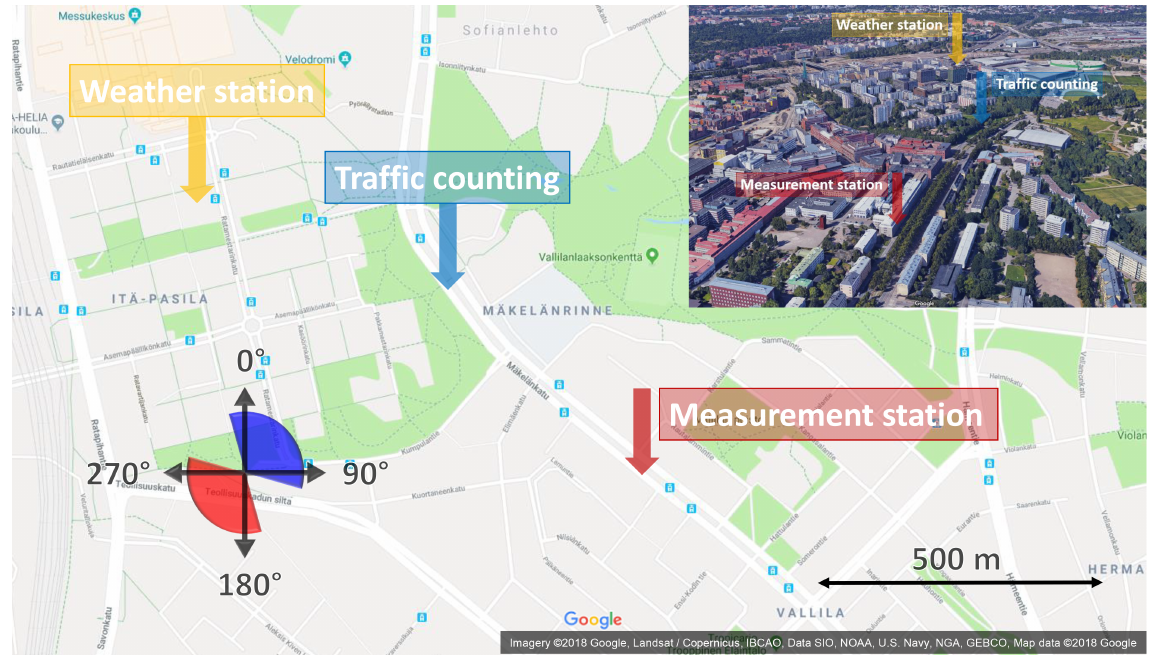
Figure 1. The map of the measurement site. Red and blue sectors denote the wind directions which result in the flow field coming from the street direction and from the background direction, respectively, towards the measurement container.